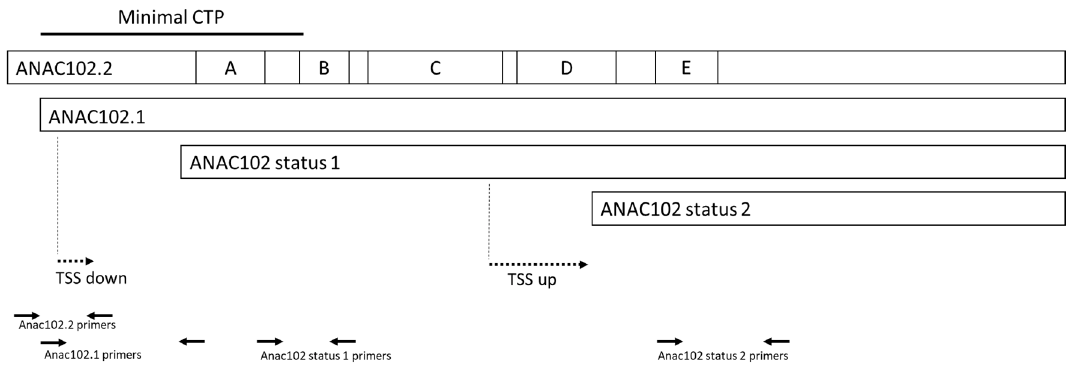
Figure 3. Schematic representation of ANAC102 putative isoforms. NAC domains (A–E). Dashed arrows = Transcription starting site (TSS), black arrows = Primer location.